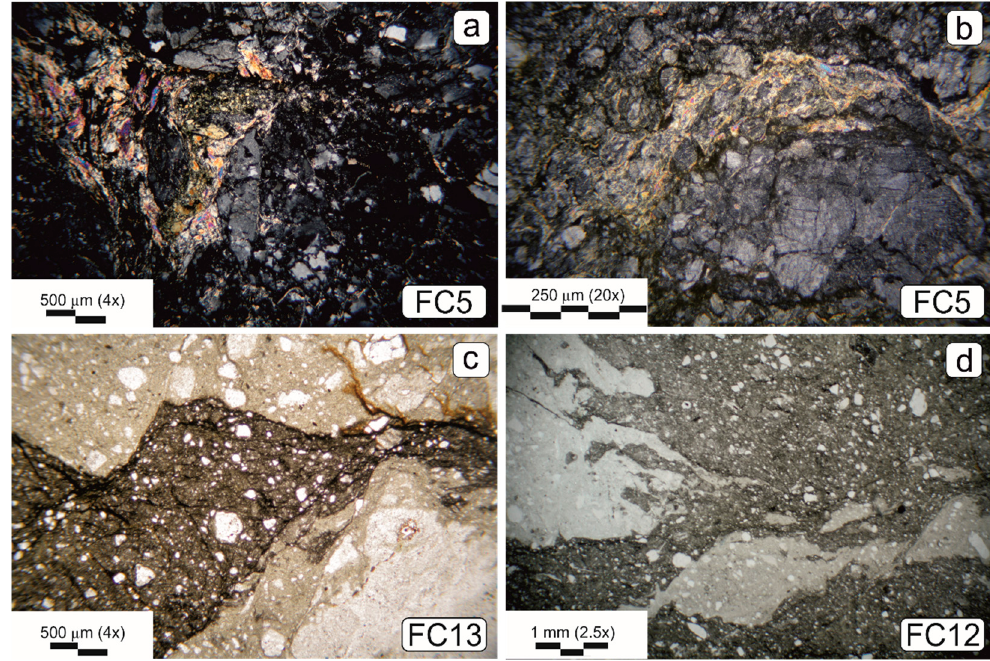
Figure 9. ( a ) Cataclastic paragneiss with partial tourmalinization. Tourmaline crystals occur in aggregates together with sericite (sample FC5). ( b ) Cataclastic quartz and plagioclase surrounded by sericitic aggregates containing a few tourmaline crystals. ( c ) The effect of tourmalinization in conglomerates-derived cataclasites (sample FC13): the original light-brown cataclasite matrix is substituted by a darker one with aphanitic tourmalinite black seams. Note the reduction in clasts grain size due to chemical reabsorption. ( d ) The effect of Boron-metasomatism on former cataclasites is inhomogeneous not only at the outcrop scale, but also at the microscopic scale. Light-colored cataclasites are preserved as millimetric domains within dark-colored tourmalinized cataclasites (sample